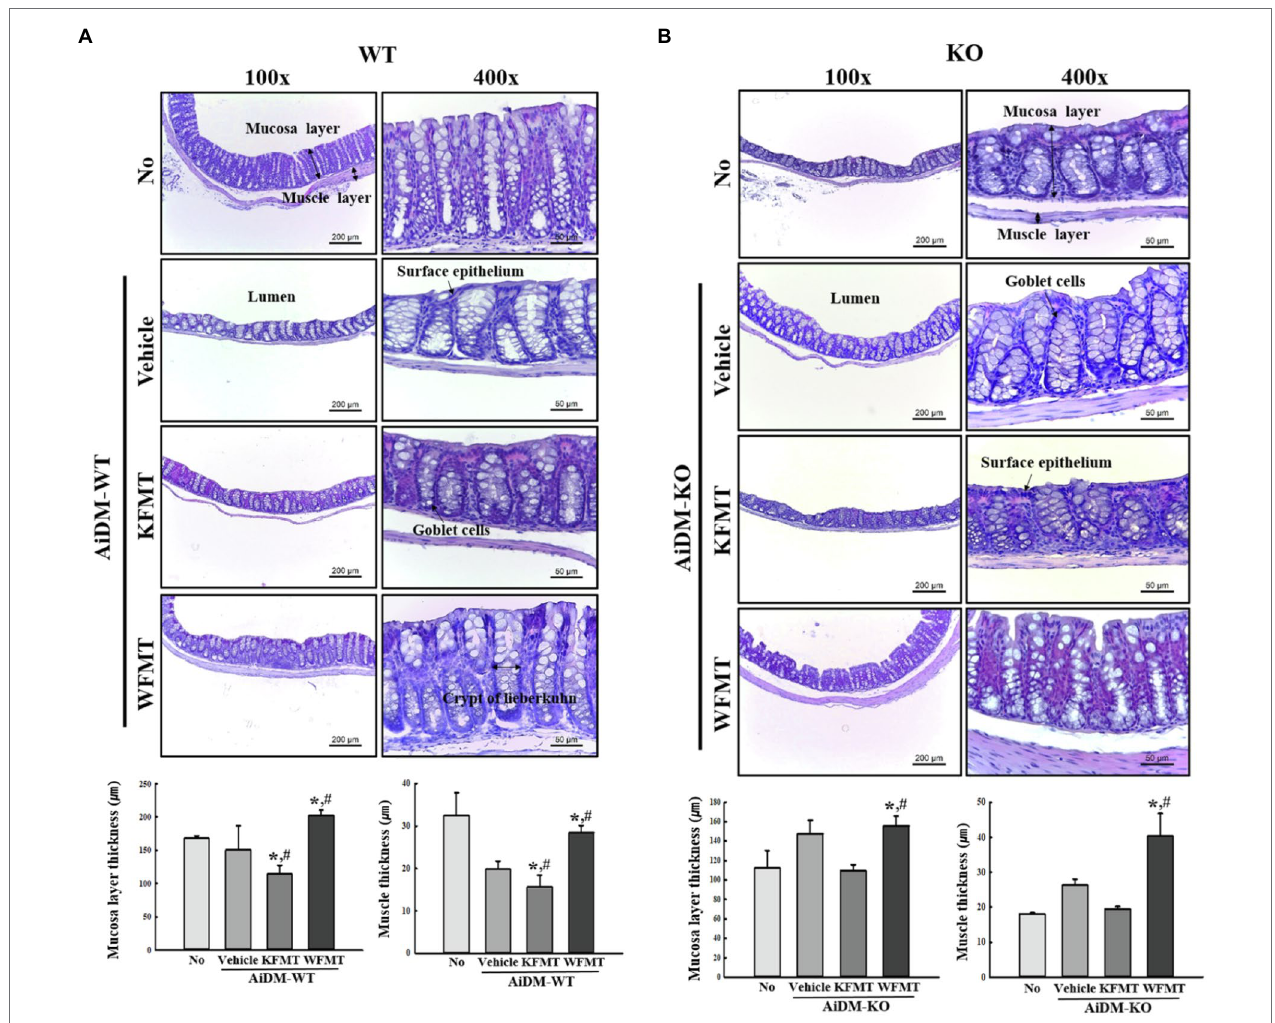
FIGURE 6 | Histopathological structures of the mid-colon in FMT mice. H&E-stained sections of mid-colons from the No-, AiDM+Vehicle-, AiDM+KMFT-, or AiDM+WFMT-treated groups in WT (A) and KO (B) mice were observed at 40× (left column) and 400× (right column) using a light microscope. Histopathological parameters were determined using the Leica Application Suite. Four to six mice per group were used to prepare H&E-stained slides, and the histopathological parameters were measured in duplicate in each slide. The data are reported as mean ± SD values. * p < 0.05 compared with the No-treated group. # p < 0.05 compared with the AiDM+Vehicle-treated group. WT, wild type; KO, knockout; FMT, fecal microbiota transplantation; KFMT, knockout mice FMT; WFMT, wild-type mice FMT; AiDM, antibiotics-induced depletion of microbiota; AiDM-WT, AiDM-wild-type mice; and AiDM-KO, AiDM-knockout